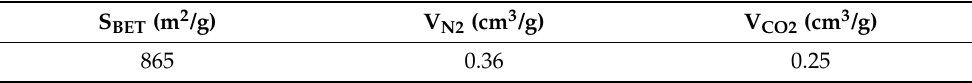
Table 1. Characterization of the porosity of Activated Carbon